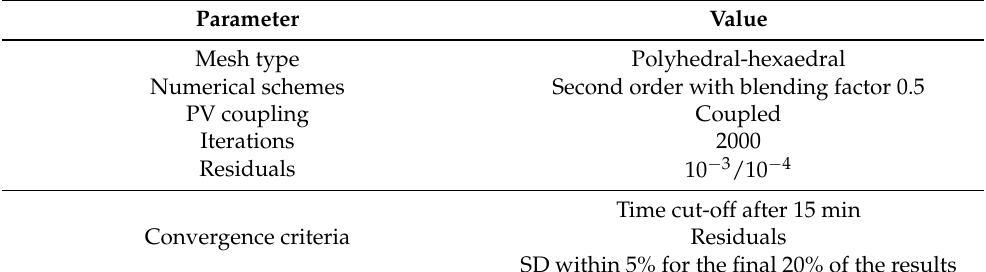
SD within 5% for the final 20% of the